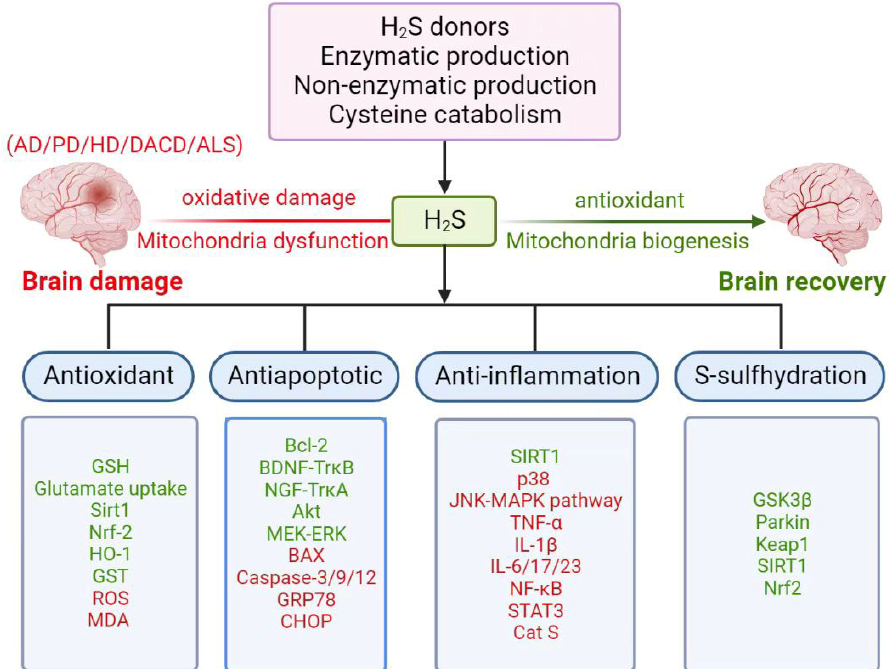
Figure 4. Overview of H 2 S in regulating neurodegenerative diseases.